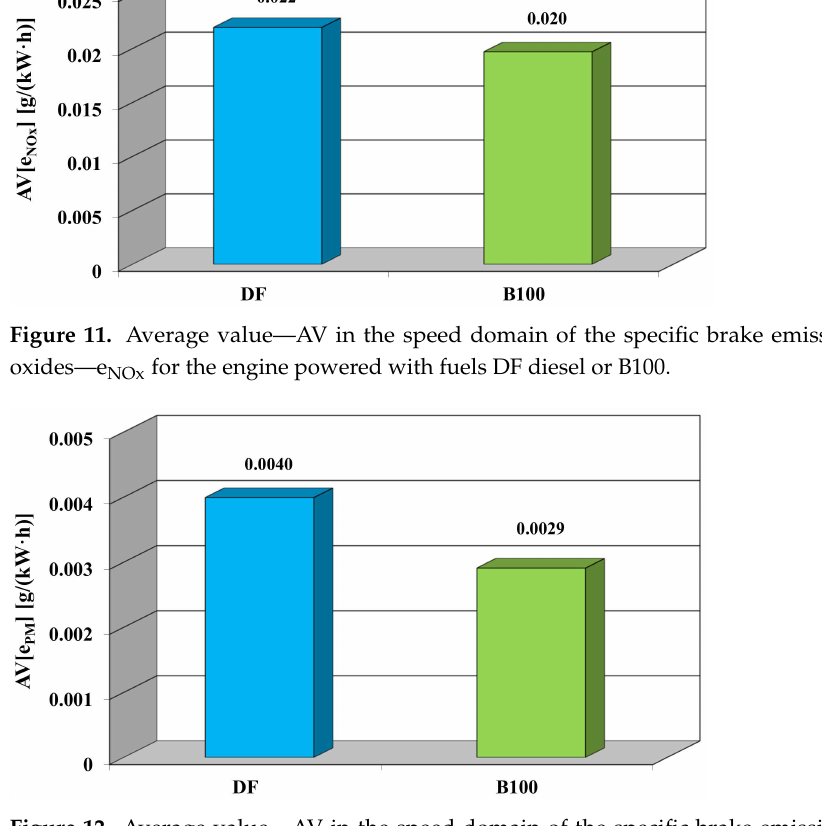
Figure 12. Average value—AV in the speed domain of the specific brake emission of particulate matter—e PM the engine powered with fuels DF diesel or B100.